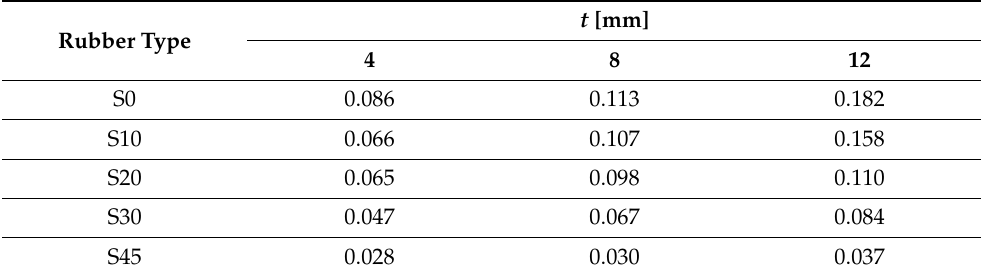
Table 6. Values of noise reduction coefficient (NRC) of the studied rubber composites.